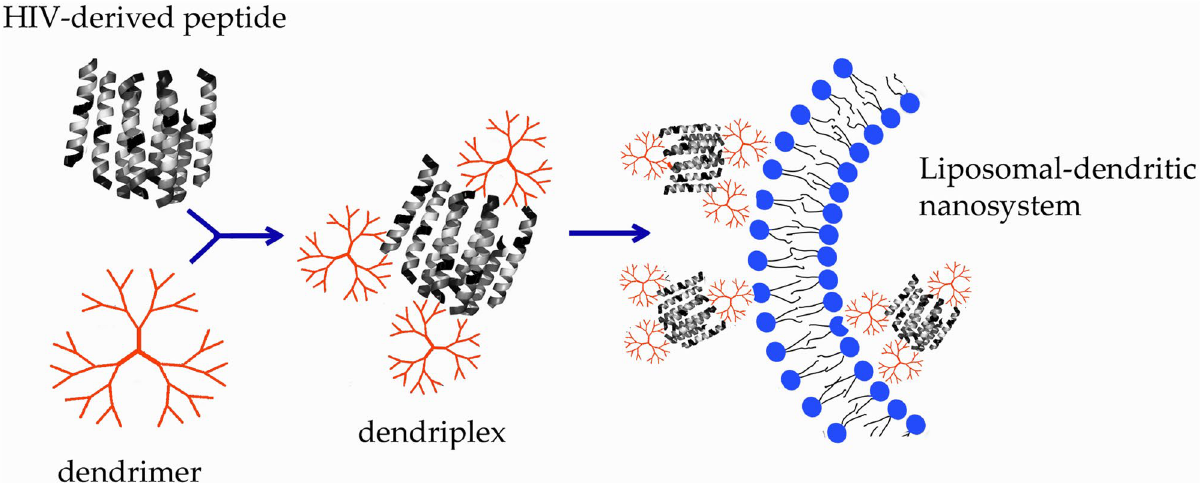
Figure 1. Schematic presentation of the interaction of peptide/dendrimer complexes and liposomal